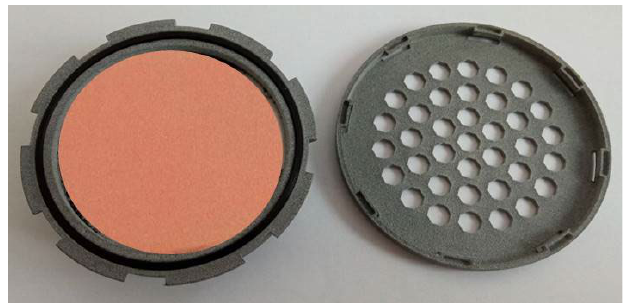
Figure 4. The half-face mask holder with a produced Cu filter.